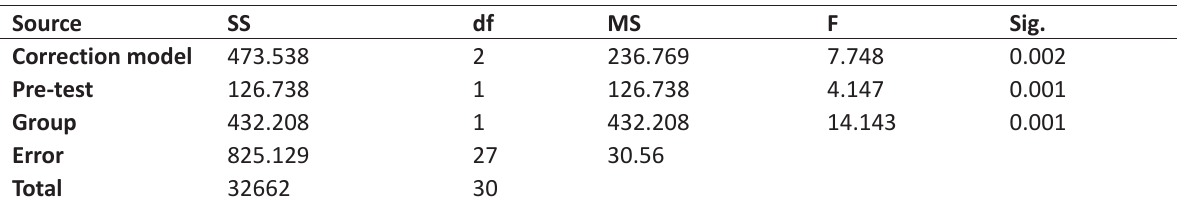
Table 4. Results of the covariance analysis test to investigate the effect of two educational methods on basketball shot